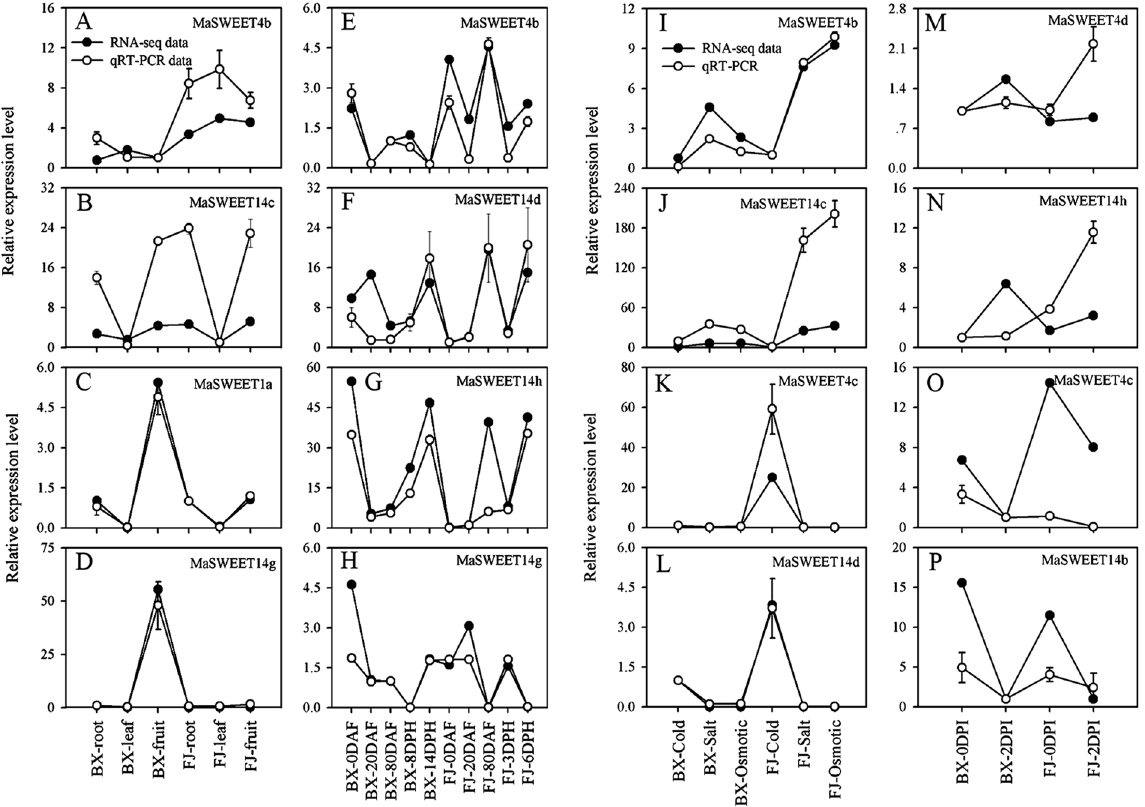
Figure 8. Relative expression of MaSWEETs in BX and FJ banana varieties by qRT-PCR. ( A – D ) Expression of MaSWEET - 4b , - 14c , - 1a and - 14g in different organs. ( E – H ) Expression of MaSWEET - 4b , - 14d , - 14h and - 14g at different stages of fruit development and ripening. ( I – L ) Expression of MaSWEET - 4b , - 14c , - 4c and - 14d in response to cold, salt and osmotic stresses. ( M – P ) Expression of MaSWEET - 4d , - 14h , - 4c and - 14b in response to fungal infection. Data are presented as means ± standard deviations of n = 3 biological